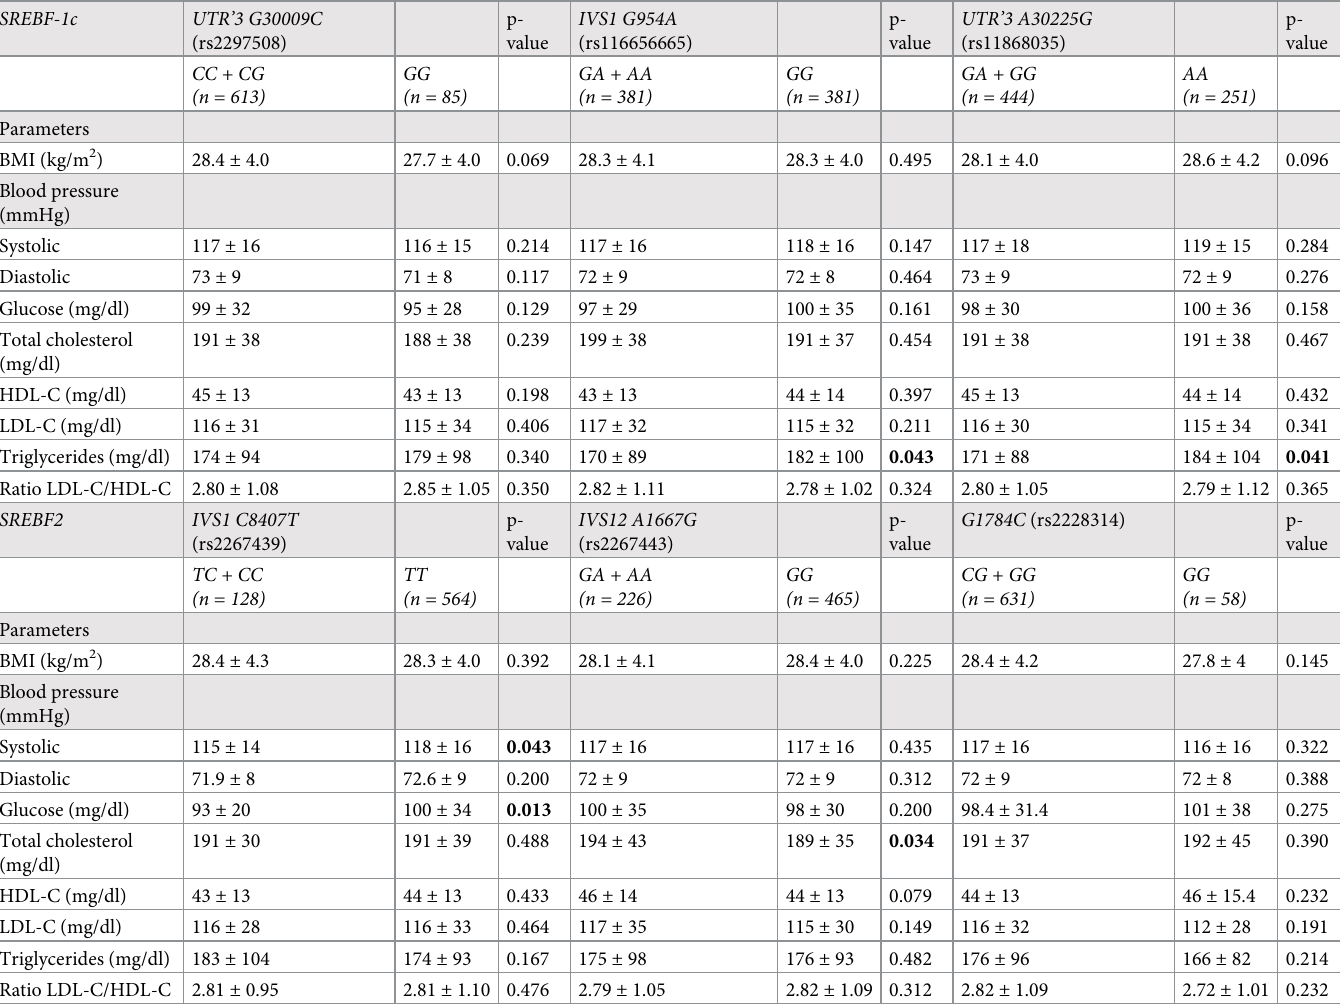
Table 4. Association of the SREBF1c and SREBF2 gene SNPs with plasma lipids levels and anthropometric characteristics in the healthy control group ( n = 700 ).